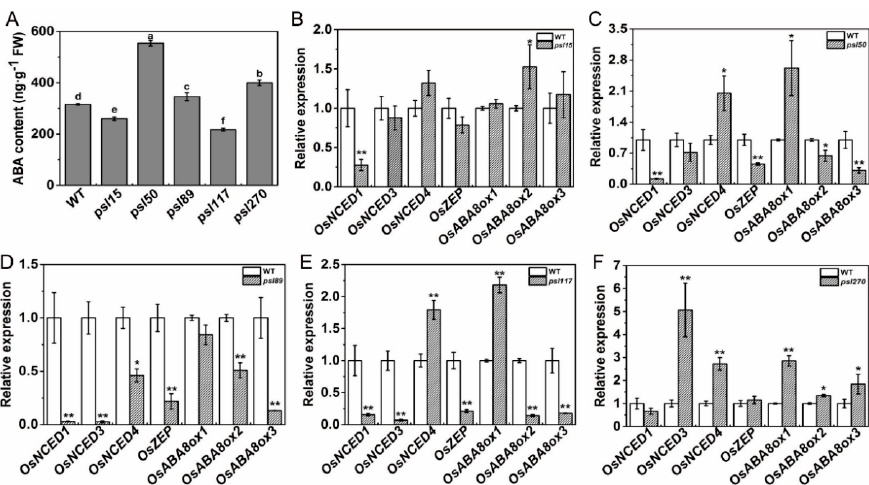
Figure 6. ABA contents and expression of ABA-related genes at the heading stage. ( A ) ABA contents in the flag leaves; ( B – F ) expression of ABA-related genes including biosynthetic genes OsNCED1 ( LOC_Os02g47510 ), OsNCED3 ( LOC_Os03g44380 ), OsNCED4 ( LOC_Os07g05940 ) and OsZEP ( LOC_Os04g37619 ) and inactivation genes OsABA8ox1 ( LOC_Os02g47470 ), OsABA8ox2 ( LOC_Os08g36860 ) and OsABA8ox3 ( LOC_Os09g28390 ). Error bars indicate means ± SD ( n = 3). * p ≤ 0.05, ** p ≤ 0.01; Student t test. Different letters indicate a statistical difference at p ≤ 0.05 by Duncan’s test.